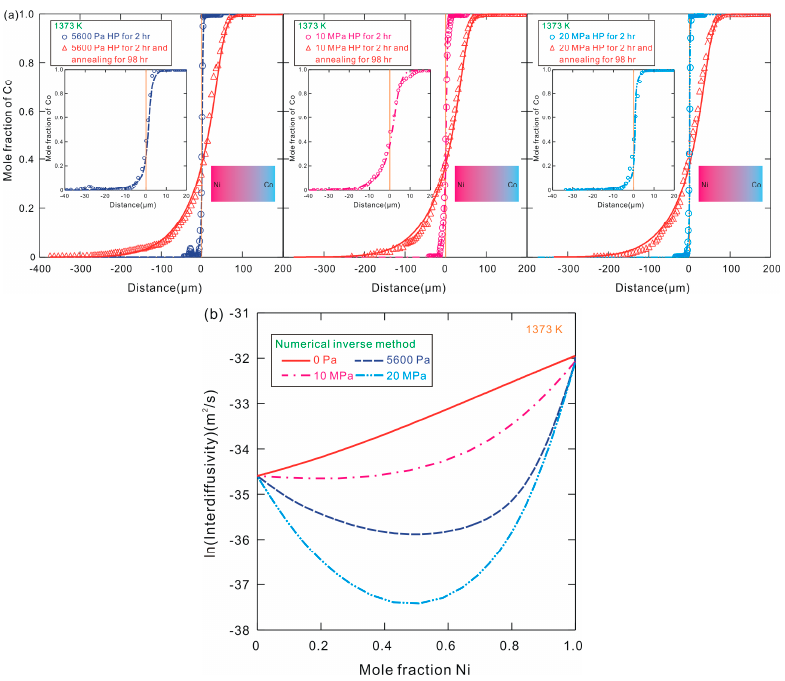
Figure 4. ( a ) Composition profiles and ( b ) natural logarithm of the corresponding interdiffusivities for Co–Ni diffusion couples after hot-pressing at 1373 K for 2 h under different stresses and annealing in a quartz capsule at 1373 K for 98 h. Symbols designate the data from the measurements in the present work while solid and dash lines are the simulated data from the pragmatic numerical inverse method.